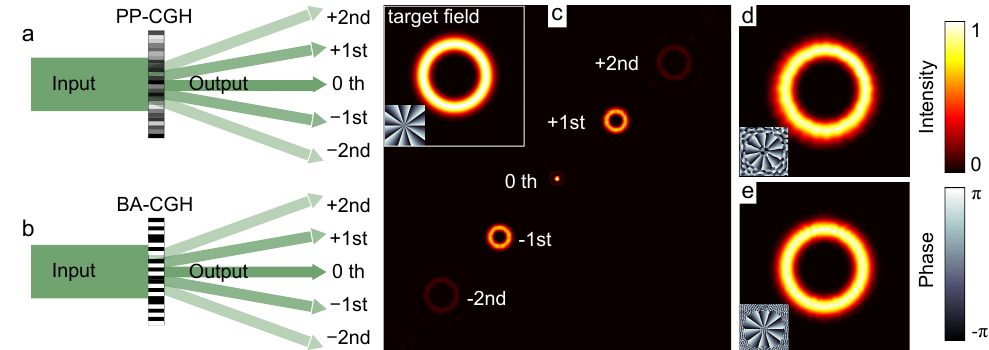
Figure 3. Schematic diagram of PP-CGH and BA-CGH for generating structured light. ( a , b ) show that the input beam is modulated and diffracted into multiple orders for the binary amplitude hologram and phase gray hologram, respectively. ( c ) shows the partially separated orders on the far-field pattern of binary amplitude or phase gray diffracted hologram of LG 10 mode by illuminating a plane 0 wavefront, while the intensity and phase of target beam are inserted in the upper left corner. ( d , e ) shows the reconstructed intensity and phase by extracting the +1st diffraction order for PP-CGH and BA-CGH,